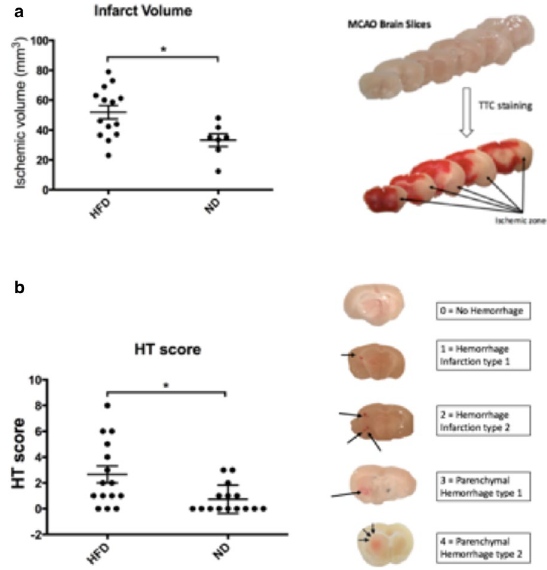
Fig. 1 Eight weeks of HFD increase ischemic volume and hemorrhagic transformation. (A)‑Infarct volume (V) 24 h after reperfusion, all value are mean SEM, HFD: V 51.66 4.46 mm 3 , n 14, ND: V 33.23 4.26 ± = ± = = ± mm 3 , n 7, *p 0.016 (B)—Hemorrhage Transformation (HT) score = = 24 h after MCAO. All value are mean SEM HFD: HT score 2.67 0.66, ± = ± n 15, ND: HT score 0.73 / 0.28, n 15 *p 0.012 = = + + = =